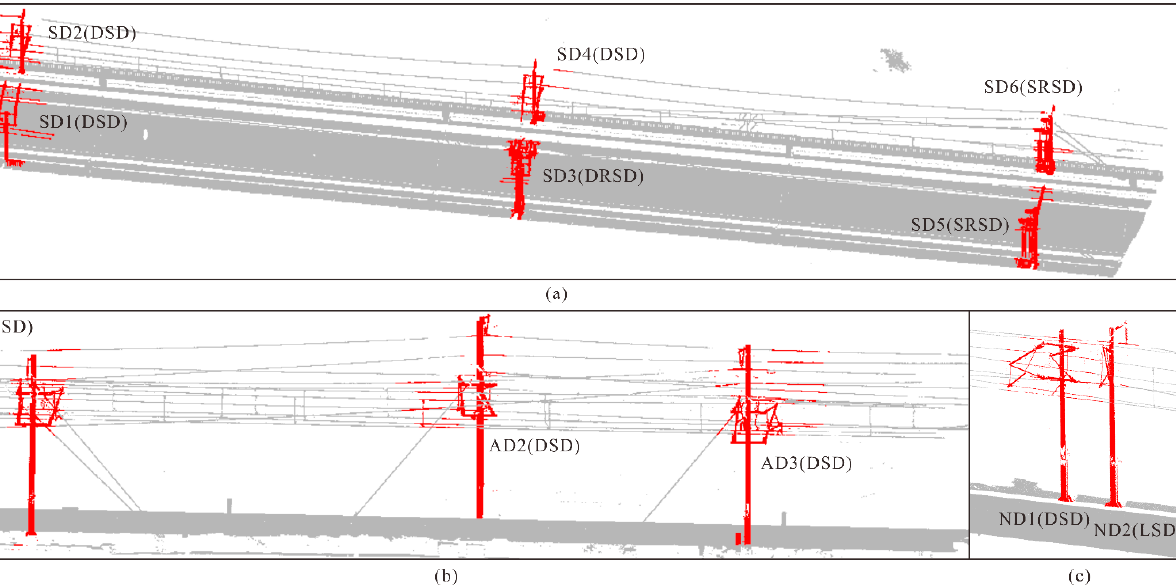
Figure 7. Display diagram of the six types of support devices: ( a ) the original image of the support device, ( b ) the SSD, ( c ) the DSD, ( d ) the SRSD, ( e ) the DRSD, ( f ) the SFSD, and ( g ) the LSD.